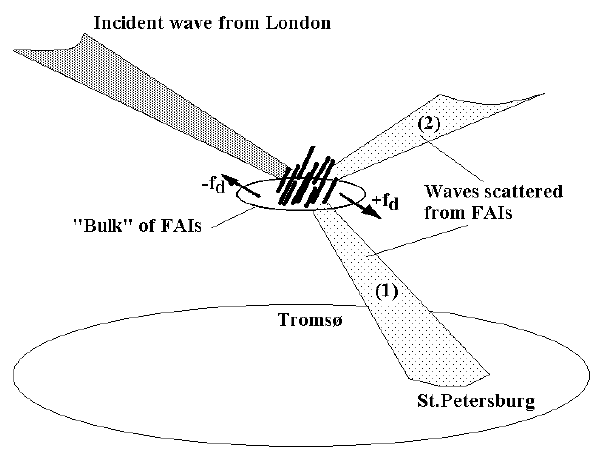
Fig. 3. Sketch of the geometry of the scattered signals from moving field-aligned irregularities. Digits (1) and (2) correspond to the dif- ferent modes of the signals scattered from FAIs above Troms. Signs “+” and “–” in Doppler frequency shift are in accordance with the movements of FAIs in the direction of the receiver ( + f d ) and from the receiver ( − f d ).